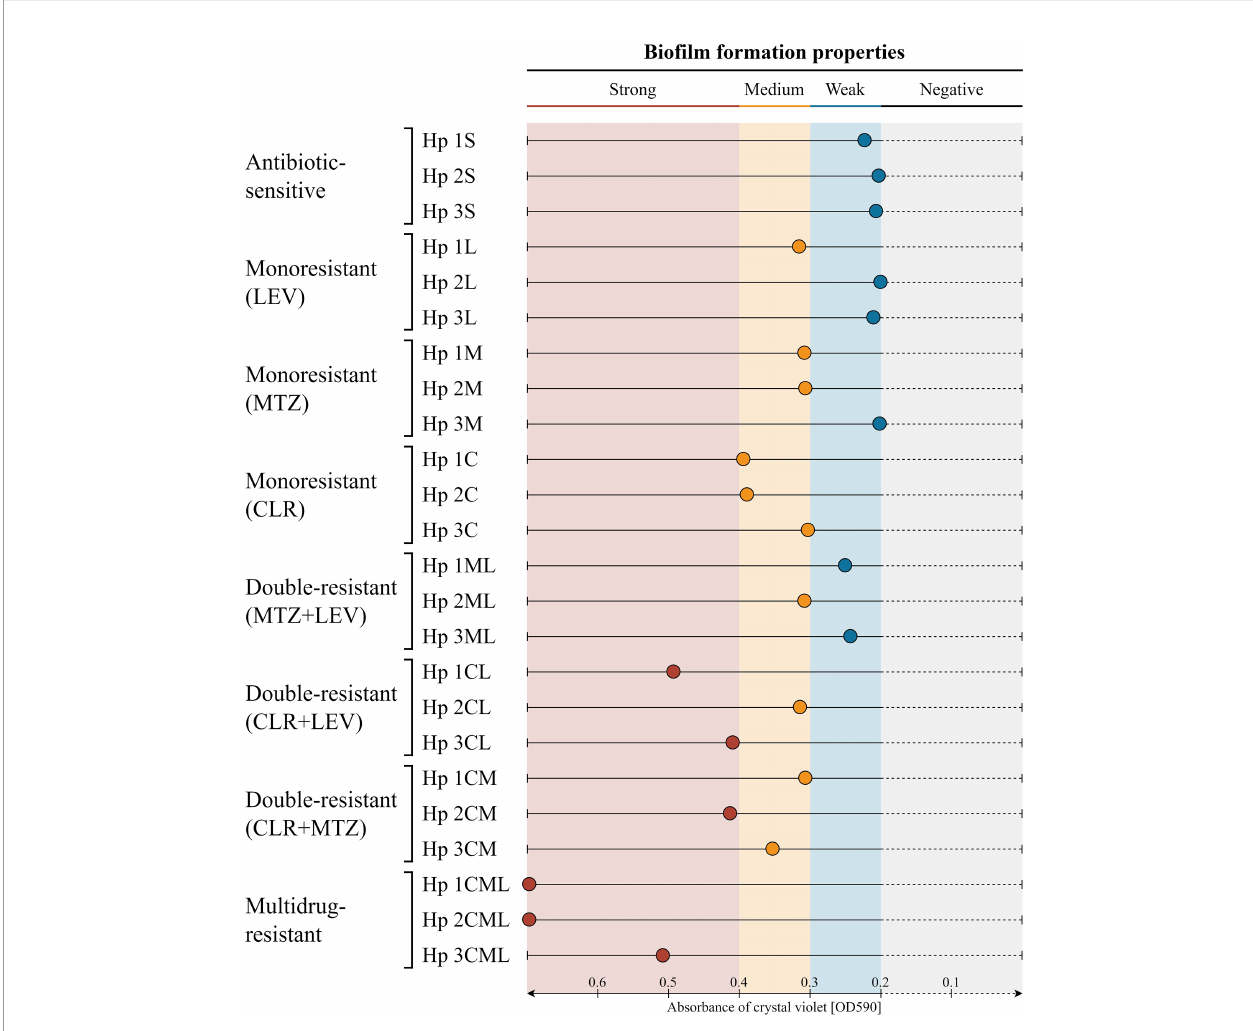
FIGURE 1 | Graphical representation of the bio fi lm formation of 24 clinical H. pylori strains in static conditions and a 3-day incubation, determined using a crystal violet staining method. The H. pylori strains were classi fi ed as strong, medium and weak bio fi lm producers when the OD 590 of the crystal violet solution was equal to ≥ 0.4, 0.4 - 0.3, 0.3 - 0.2, respectively. Values obtained for the pure medium, being a negative control, were < 0.2 and indicated the lack of bio fi lm production by the tested strain. The tests were performed in three biological replications with six technical repetitions (n = 18/strain). CLR, clarithromycin; MTZ, metronidazole; LEV, levo fl